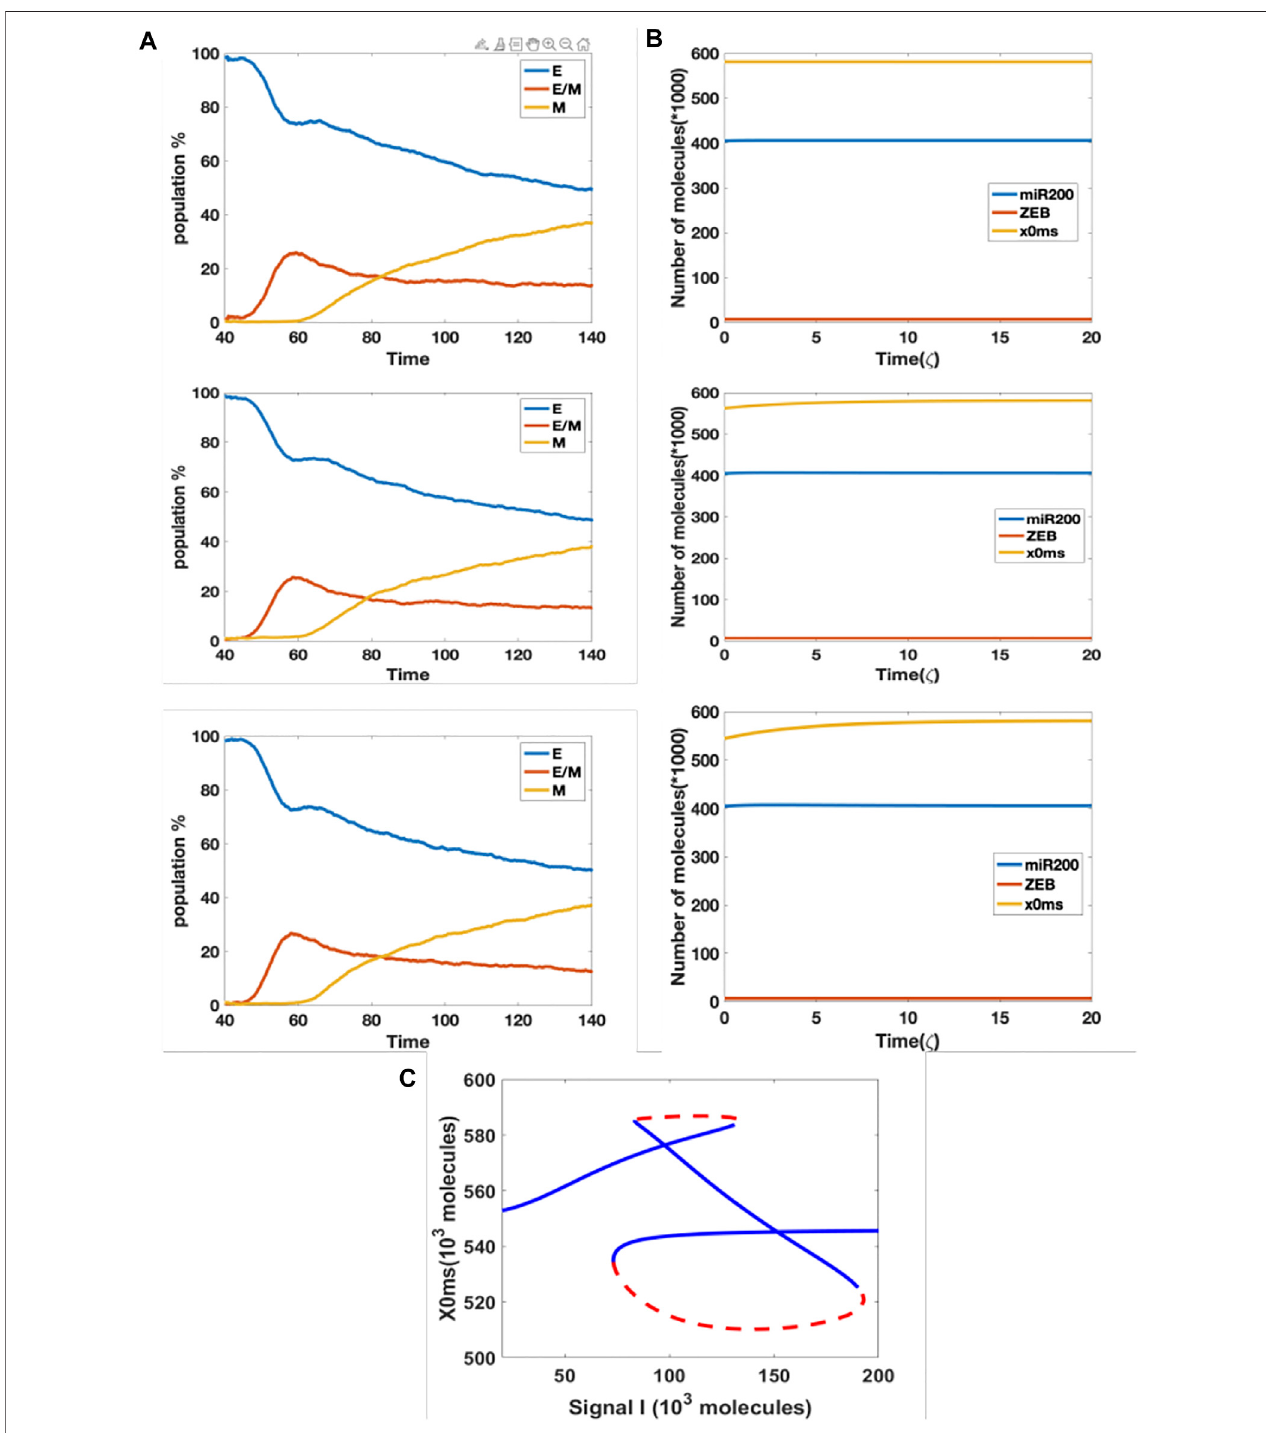
FIGURE5|(A) Populationchangesasafunctionoftimeinamodelincludingbothcelldivisionandepigeneticregulation,andwherethenoiseofthethresholdx0ms is increasing (top (cid:1) 0 k, median (cid:1) 100 K, bottom (cid:1) 300 K). (B) Dynamic example for different initial x0ms values (top (cid:1) 581.2 K, median (cid:1) 562.5 K, bottom (cid:1) 544.6 K; thesearestablevaluesofx0mswhen I (cid:1) 120from Figure4C ). (C) Bifurcationdiagramforx0msbasedoninpitsignalI,forthemodelincludingbothepigeneticregulation on SNAIL ’ s inhibition from NRF2 and NRF2 ’ s inhibition from Keap1.